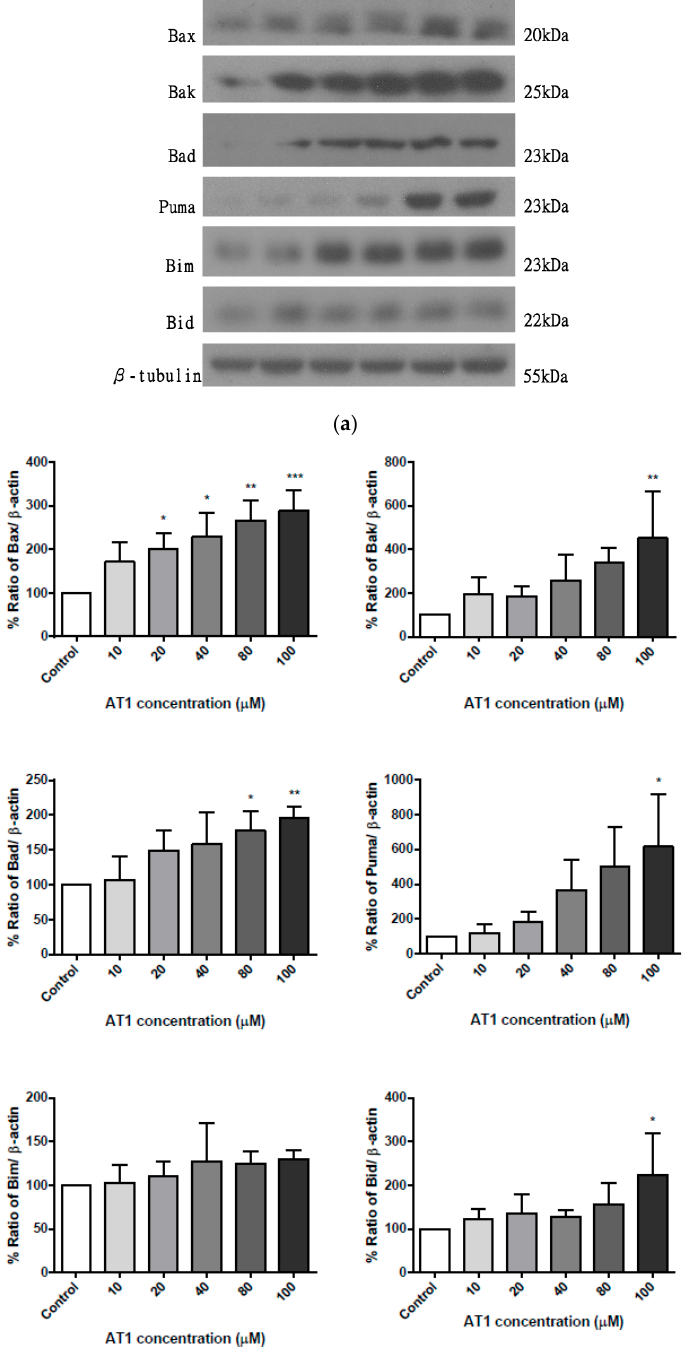
Figure 8. The effects of various concentrations of AT-I on the expression levels of the pro-apoptotic Bcl-2 family of proteins in HT-29 cells were assessed by western blotting, after cells were treated with AT-I for 48 h. The control group was not treated with AT-I. Total protein concentration of each sample was determined and normalized. β -tubulin was used as a loading control in all western blot experiments. The intensity of each band was quantified by ImageJ image processing program. ( a ) Western blot images of Bax, Bak, Bad, Puma, Bim, Bid and β -tubulin. The images are representative of three independent experiments. ( b ) Each bar chart presents the percentage ratio of each investigated protein to β -tubulin. Data are shown as mean ± SD, n = 3. Significant differences are indicated by * p < 0.1, ** p < 0.01 and *** p < 0.001 as compared with the control group. 2.8. The Effect of AT-I on the Expression Level of the Pro-Survival Bcl-2 Family of Proteins in the HT-29 Cell Line